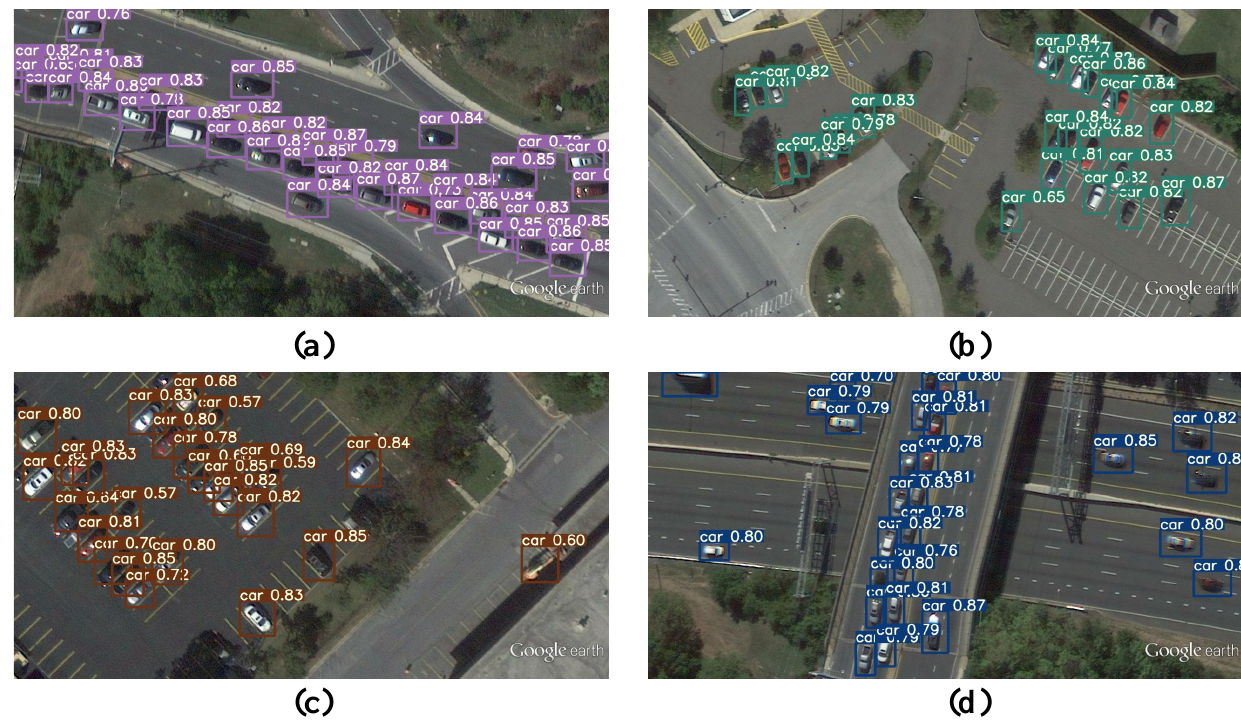
Figure 15. This is the detection result of the KCFS-YOLOv5 on the UCAS-AOD-CAR dataset. ( a – d ) are the